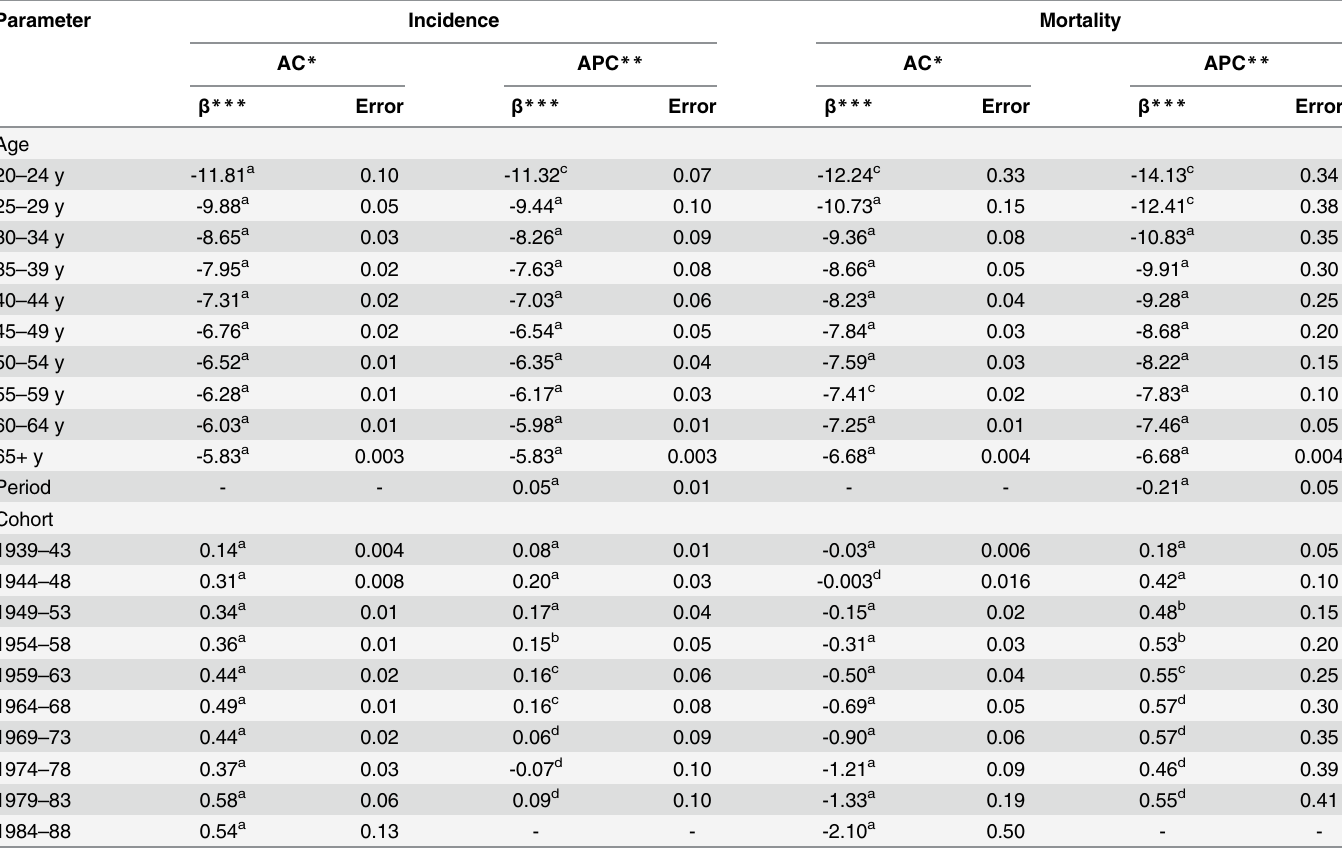
Table 3. Parameter Estimates Obtained ( β ) Using glm Modeling of Age-Cohort and Age-Period-Cohort for Incidence and Mortality of Breast Cancer. Parameter